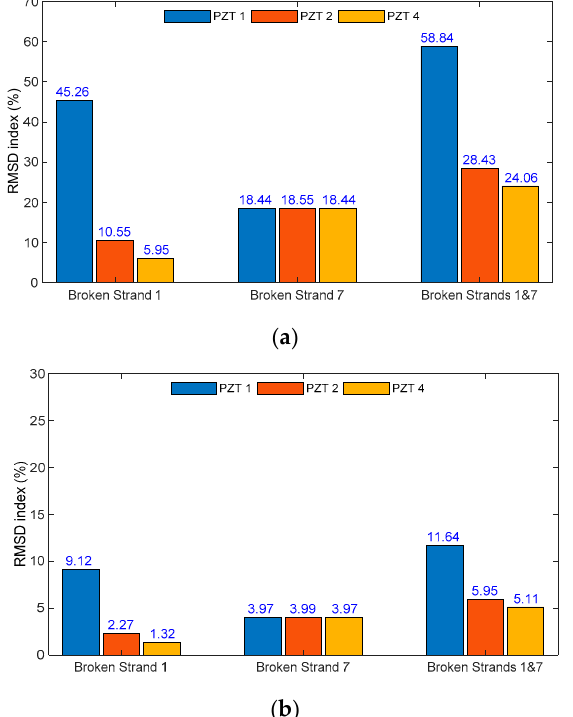
Figure 13. RMSD indices of PZT sensors’ impedance signature for locally damaged strand. ( a ) Peak 1’s impedance and ( b ) Peak 2’s impedance.